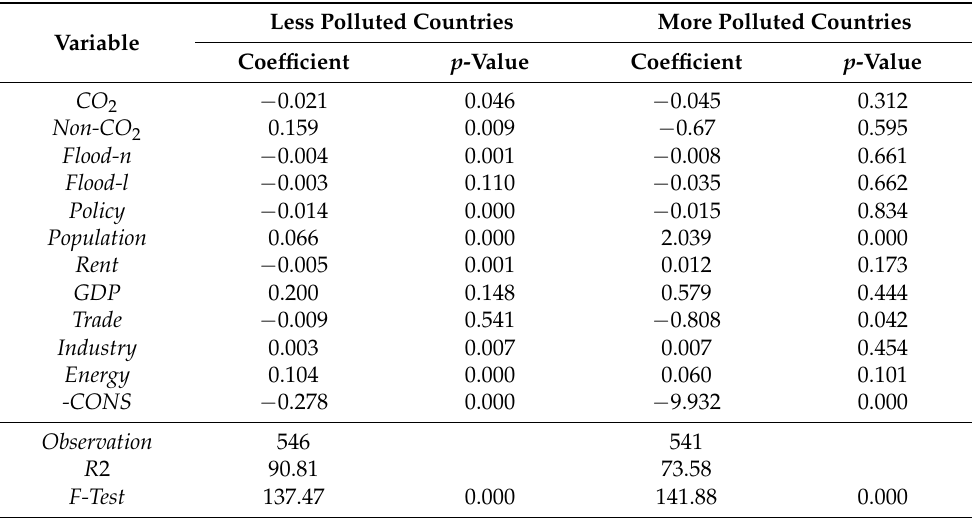
Table 8. Investment estimation results for the wind energy sector by group of polluted and less polluted